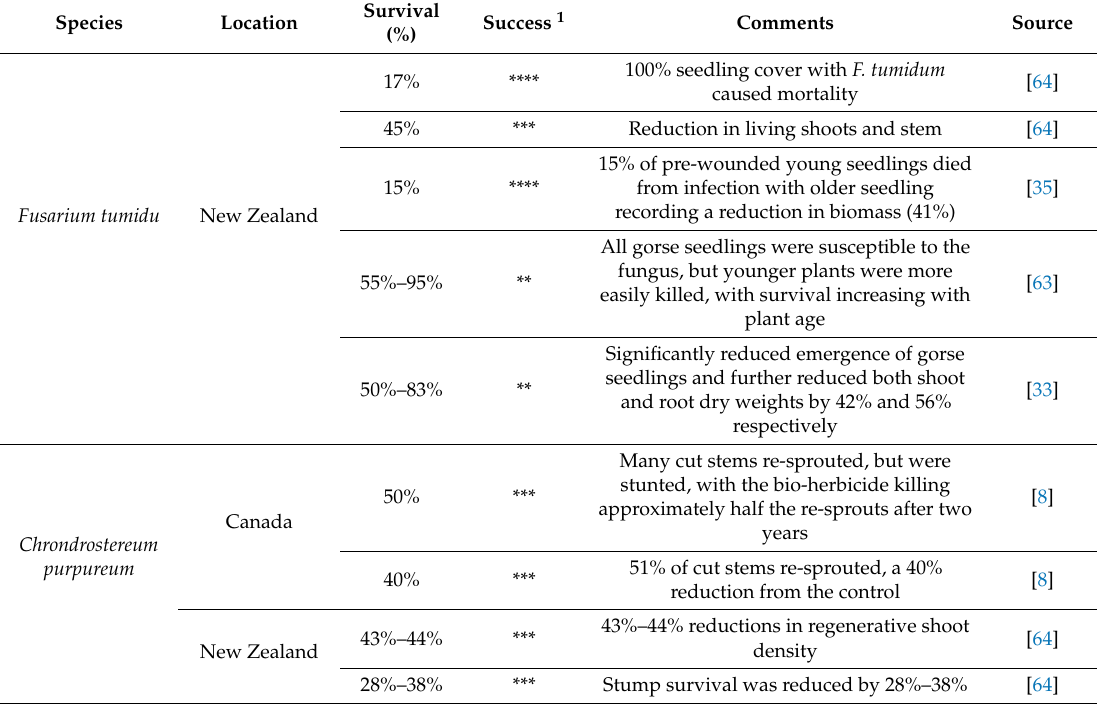
Table A3. Mycoherbicides and their success in reducing plant vigour and population size of common